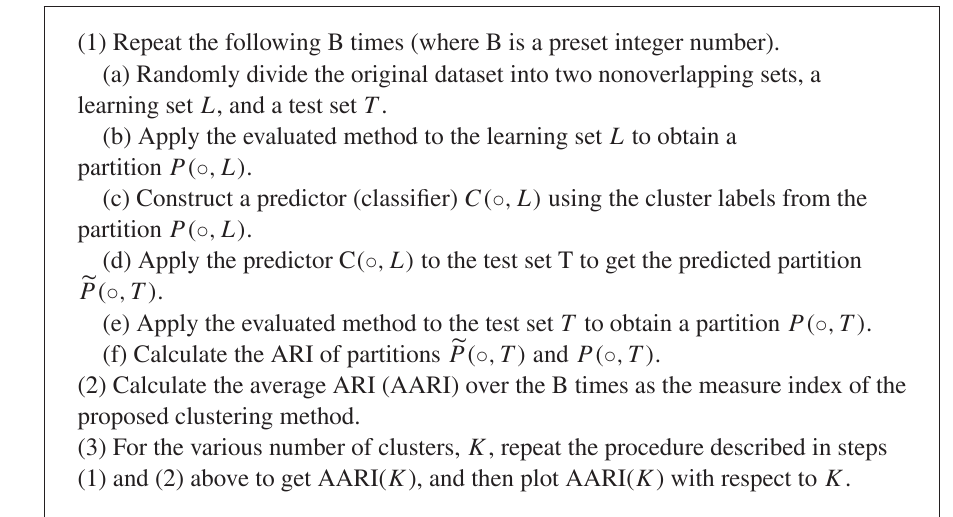
Algorithm 2: The procedure for evaluating proposed clustering method.